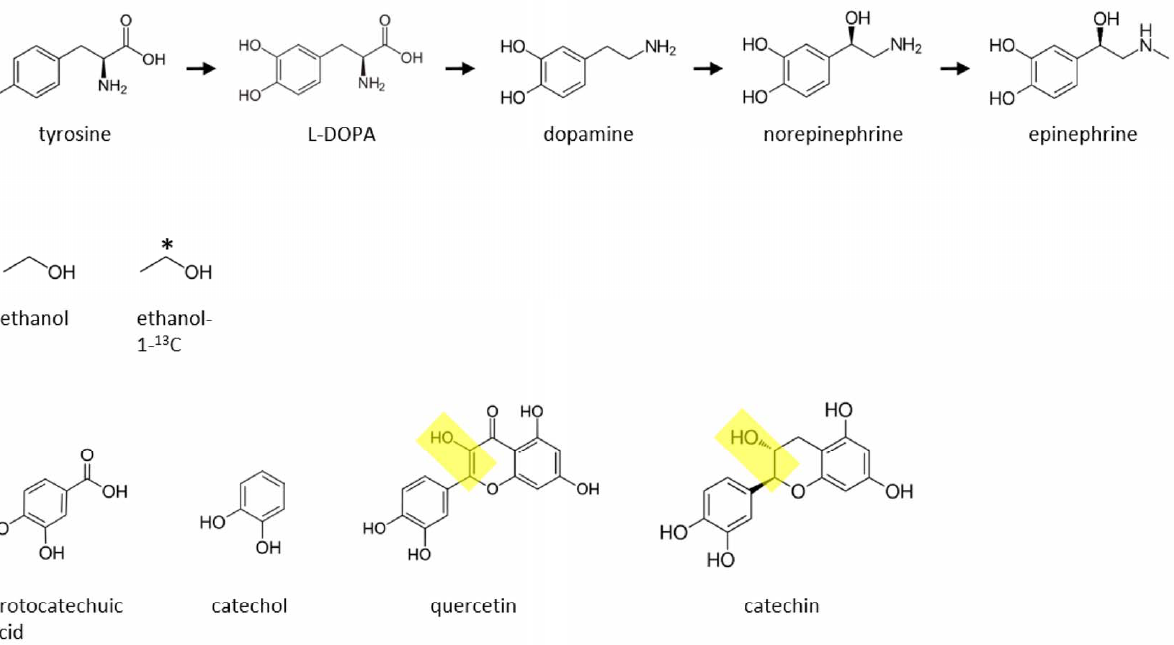
Figure 1. Canonical pathway for the endogenous synthesis of catecholamines and possible additional pathways involving ethanol. This pathway was described over 70 years ago, and posits that there is a single, principal biosynthetic pathway in mammals that converts the amino acid tyrosine to dopamine (via L-DOPA), and subsequently to norepinephrine and epinephrine ( A ). The middle portion of the figure ( B ) shows the structure of C12 unlabeled ethanol (left) and the C13 labeled ethanol (right) proposed to be used here. The * indicates where the C13 is located within the molecule. ( C ) Various plant-derived phenylic molecules that may combine with ethanol in vivo to produce catecholamines. Yellow boxes highlight an ethanol-like moiety already present within the flavonoids quercetin and catechin, that could lead to biotransformation to catecholamines even in the absence of